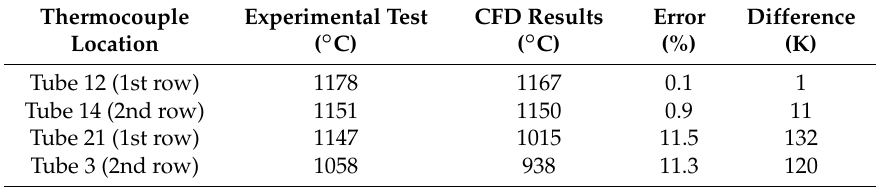
Table 2. Comparison of experimental temperature and CFD